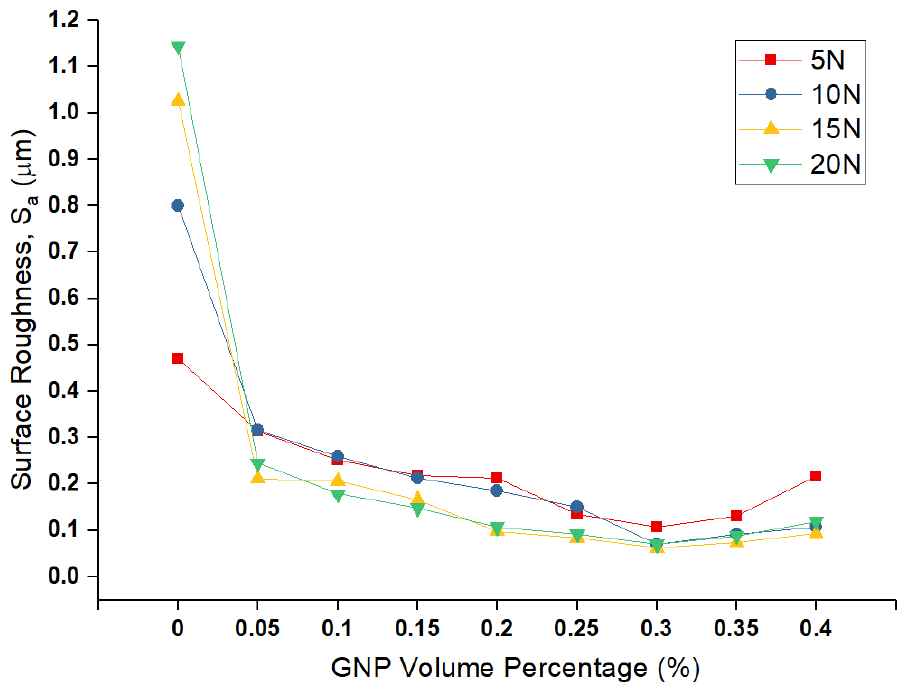
Figure 7. Surface roughness of worn surfaces of pins in several GNPs at different loads.